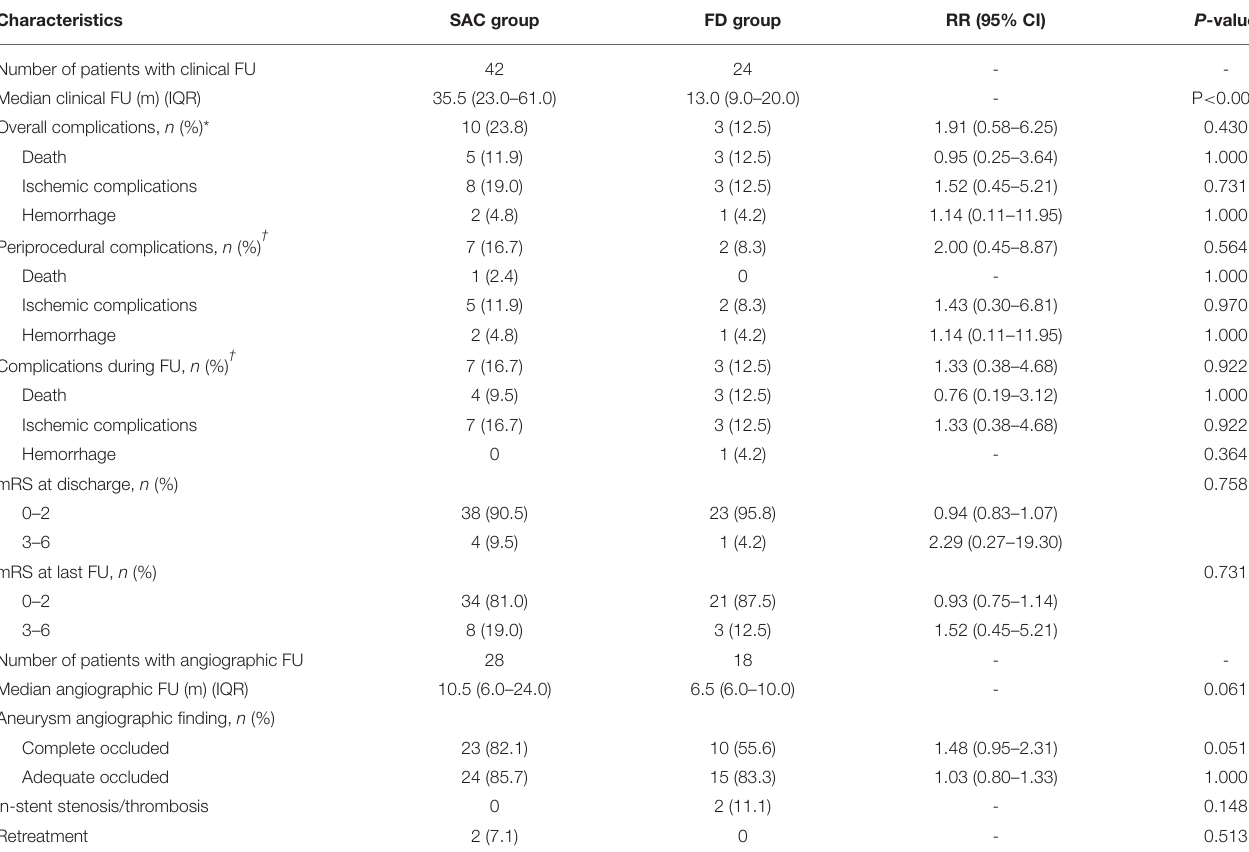
TABLE 3 | Treatment and angiographic outcome of patients.